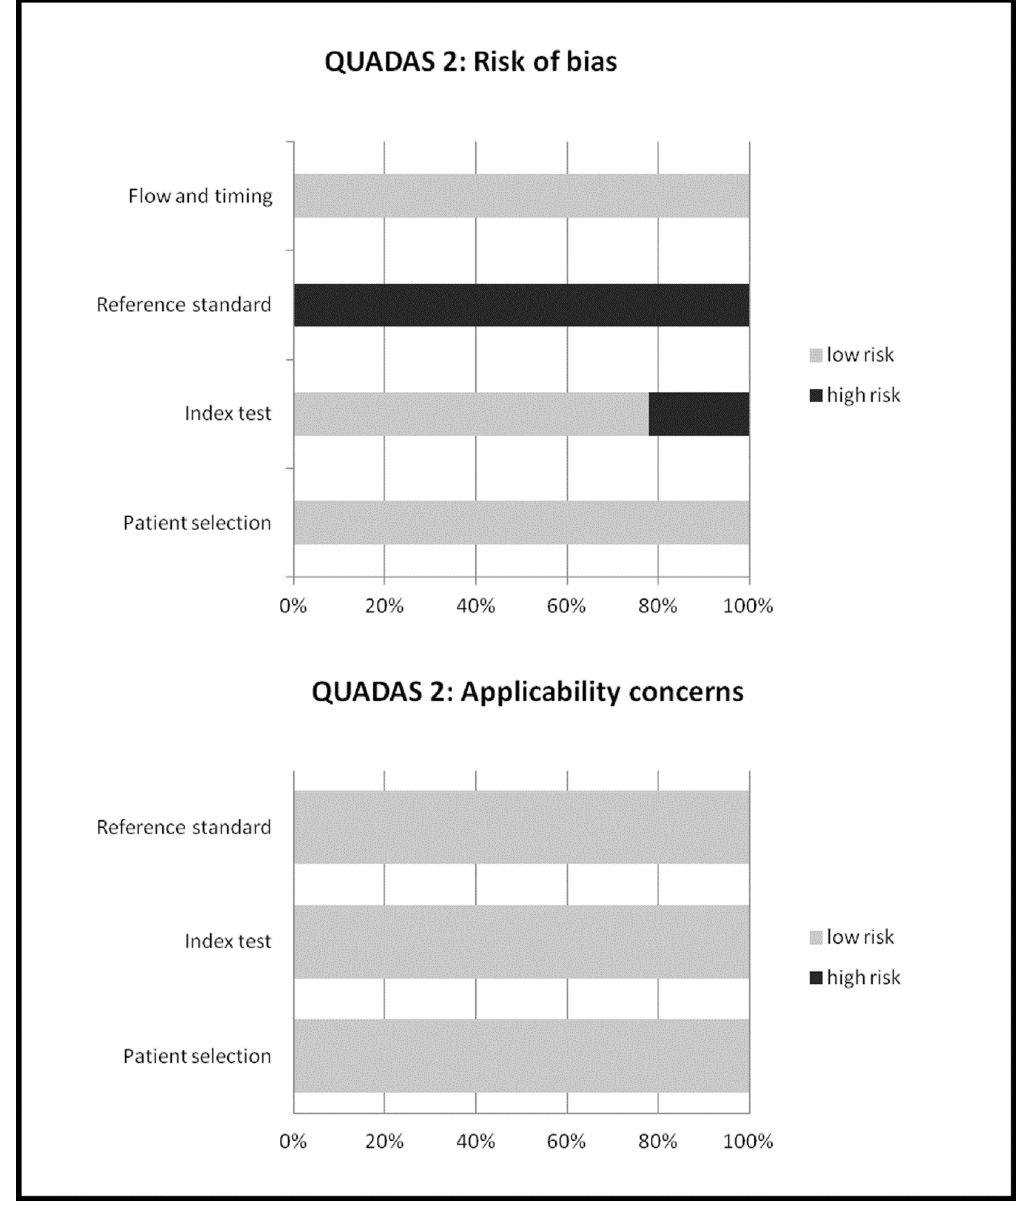
Figure 2. Overall quality assessment of the studies included in the systematic review according to the QUADAS-2